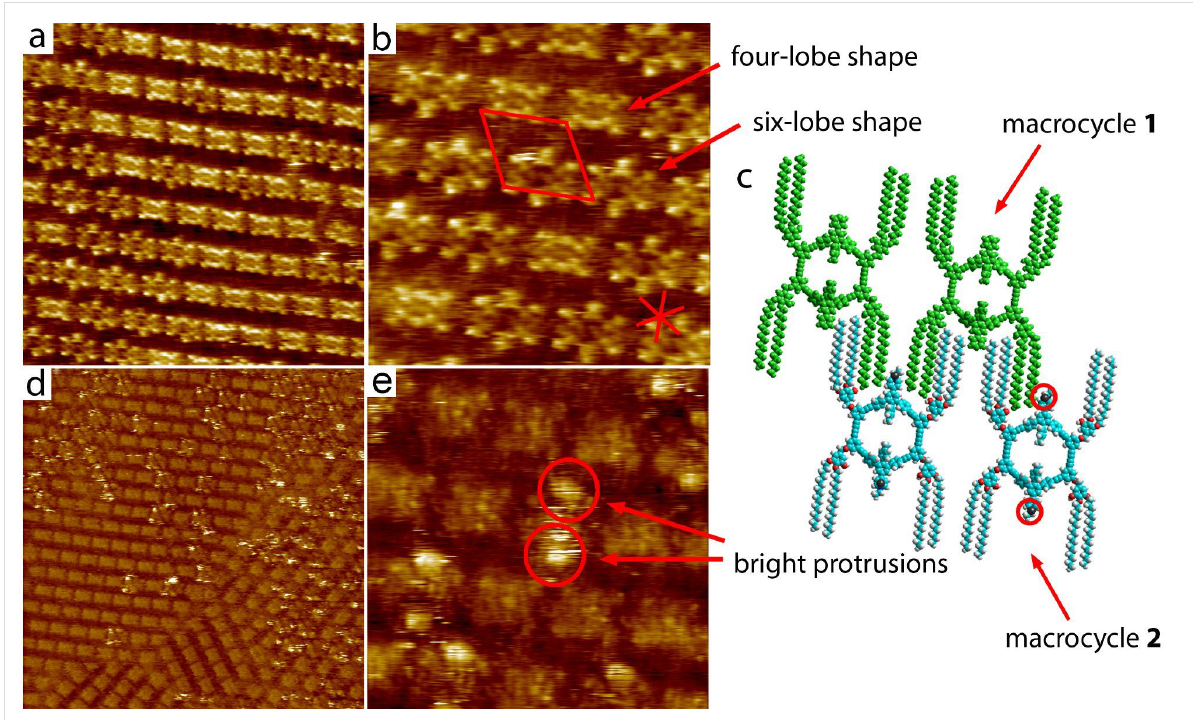
Figure 3: STM images and tentative molecular packing model of macrocycle 2 and 1 co-self-assembled at the trichlorobenzene/graphite interface. The unit cell parameters are a = 4.7 ± 0.2 nm, b = 4.4 ± 0.1 nm, γ = 65 ± 3°. a) 37.5 nm × 37.5 nm i T = 67 pA, V S = − 554 mV. b) High resolution STM image, 17.2 nm × 17.2 nm, i T = 45 pA, V S = − 554 mV, the unit cell and the orientations of the main crystallographic directions of the underlying graphite surface are indicated in red. c) Schematic representation of the tentative packing model of co-self-assembly of macrocycle 2 (bottom molecules) and 1 (top molecules in green). The iodide ions are depicted in black and highlighted by a red circle. Based on the STM contrasts, measurements of the area available for adsorption of alkyl chains, and the ideal periodicity for physisorbed alkanes on graphite [18,19], it can be concluded that only eight out of twelve alkyl chains per molecule are adsorbed on graphite. d) 67.8 nm × 67.8 nm, i T = 36 pA, V S = − 537 mV, e) High resolution STM image, 18.1 nm × 18.1 nm, i T = 37 pA, V S = − 561 mV.